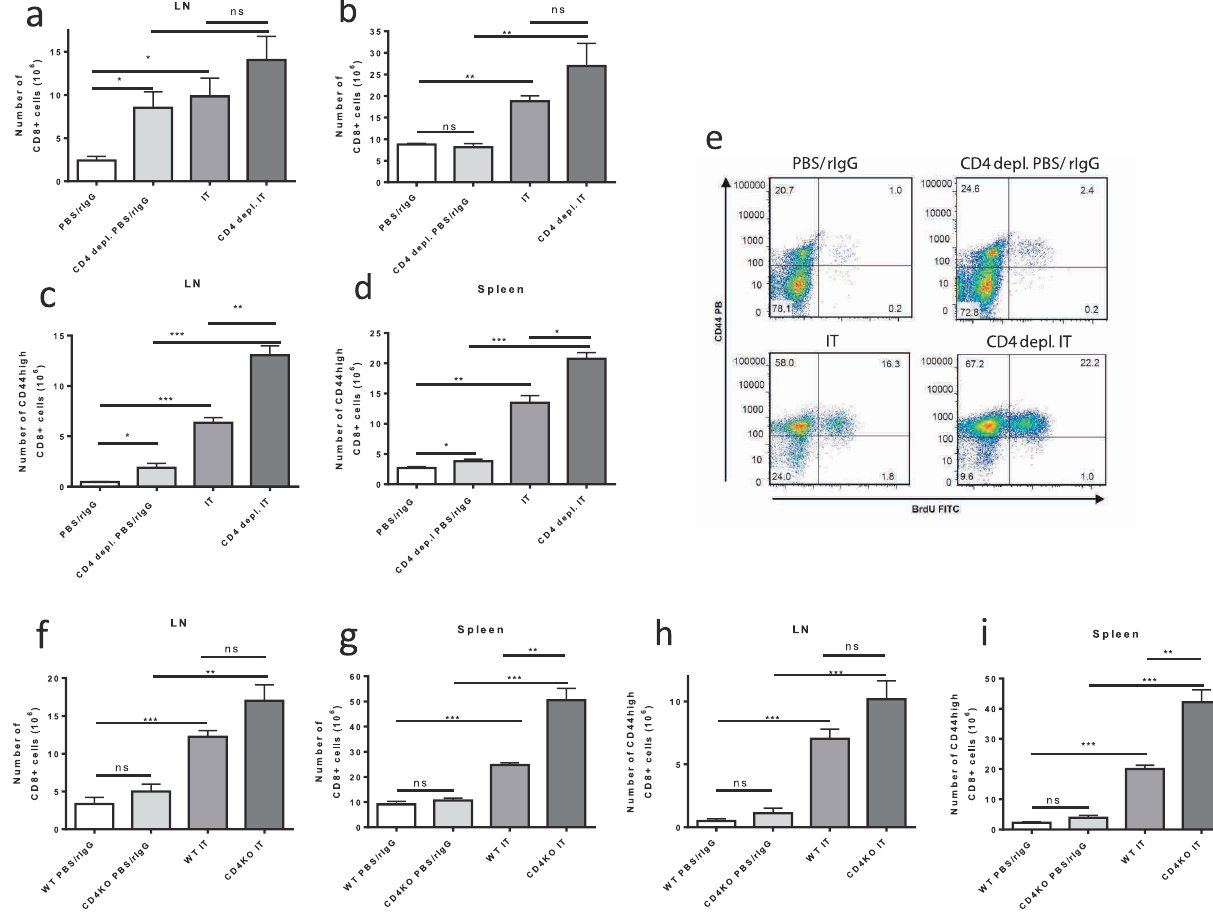
Figure 2. IT induced expansion of memory CD8 + T cells in CD4 + T cell deficient models. Control or CD4 deficient (depleted or knockout) C57BL/6 mice were treated with IT or PBS/rIgG (control) and effects on CD8 + T cell expansion were quantified by flow cytometric analysis 11 days after the initiation of IT. CD8 + ( a,b ) and memory CD8 + ( c,d ) T cell numbers in the LNs ( a,c ) and spleens ( b,d ) of control or CD4 + T cell depleted mice treated with vehicle or IT. ( e ) BrdU incorporation in CD8 + T cells from spleens of control or CD4 + T cell depleted mice treated with vehicle or IT. CD8 + ( f,g ) and memory CD8 + ( h,i ) T cell numbers in the LNs ( f,h ) and spleens ( g,i ) of wild-type or CD4 knockout mice treated with vehicle or IT. Results are representative of two (CD4 knockout) or three (CD4 depletion) independent experiments with a minimum of three mice per group. (* P , .05, ** P , .01, *** P , .001).